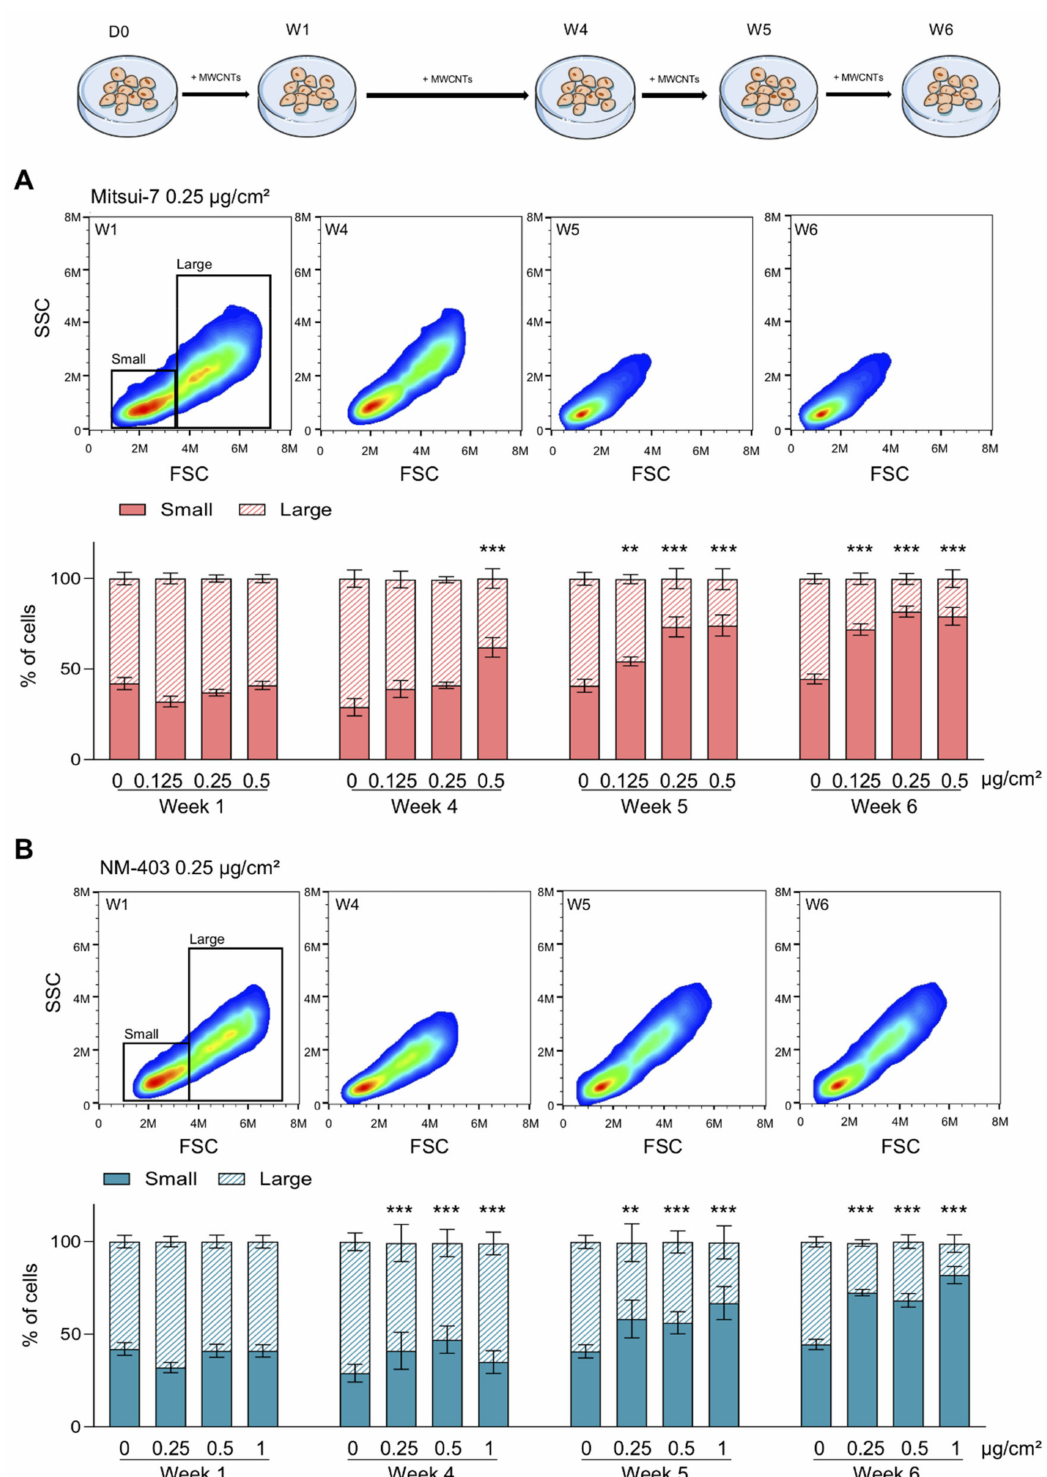
Figure 6. Mitsui-7 and NM-403 induced the selection of a cell population. The cells were treated with ( A ) Mitsui-7 (0.125, 0.25 and 0.5 µ g/cm 2 ) or ( B ) NM-403 (0.25, 0.5 and 1 µ g/cm 2 ) and their size and granulometry were analysed using flow cytometry. Based on the SSC:FSC profiles, two cell populations were determined: those of a small size and low granulometry (small) and those of a large size and high granulometry (large). The SSC:FSC profiles from W1, W4, W5 and W6 are represented for Mitsui-7 0.25 µ g/cm 2 and NM-403 0.25 µ g/cm 2 . The histograms represent the mean ± standard error of the mean (SEM) of the quantification of the two cell populations for three independent experiments. ** p < 0.01, *** p < 0.001 significantly different from the